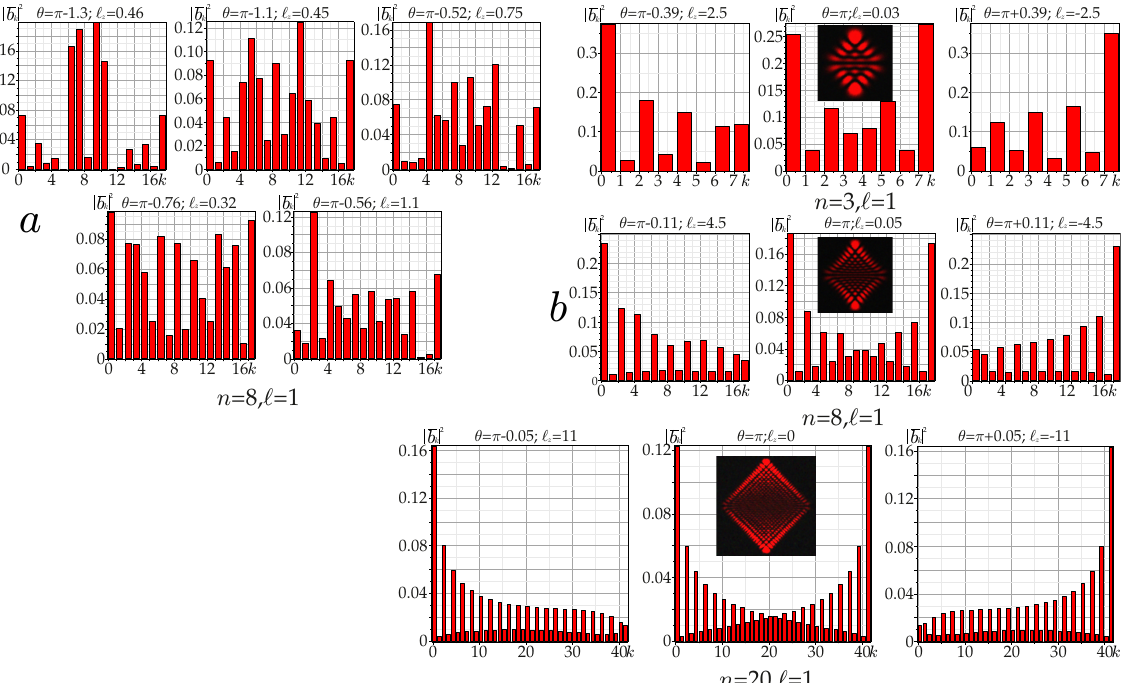
Figure 6. The LG mode spectra b k ( 1, θ , π /4 ) of asLG beams for some values of θ : ( a ) LG mode spectra far from main extremes; the first spectrum corresponds to the astigmatic invariant sLG beam with ( n , (cid:96) ) = ( 8,1 ) , and the remaining spectra correspond to a sequence of additional maxima and minima preceding the main maximum. ( b ) The LG mode spectra extremes in the vicinity of zero OAM. The inscriptions in the figures set the phase parameters θ as the maxima and minima, and the corresponding OAM (cid:96) z . The callouts show intensity patterns for zero OAM. The spectra for ( n , (cid:96) ) = ( 3,1 ) and ( 8,1 ) are experimental